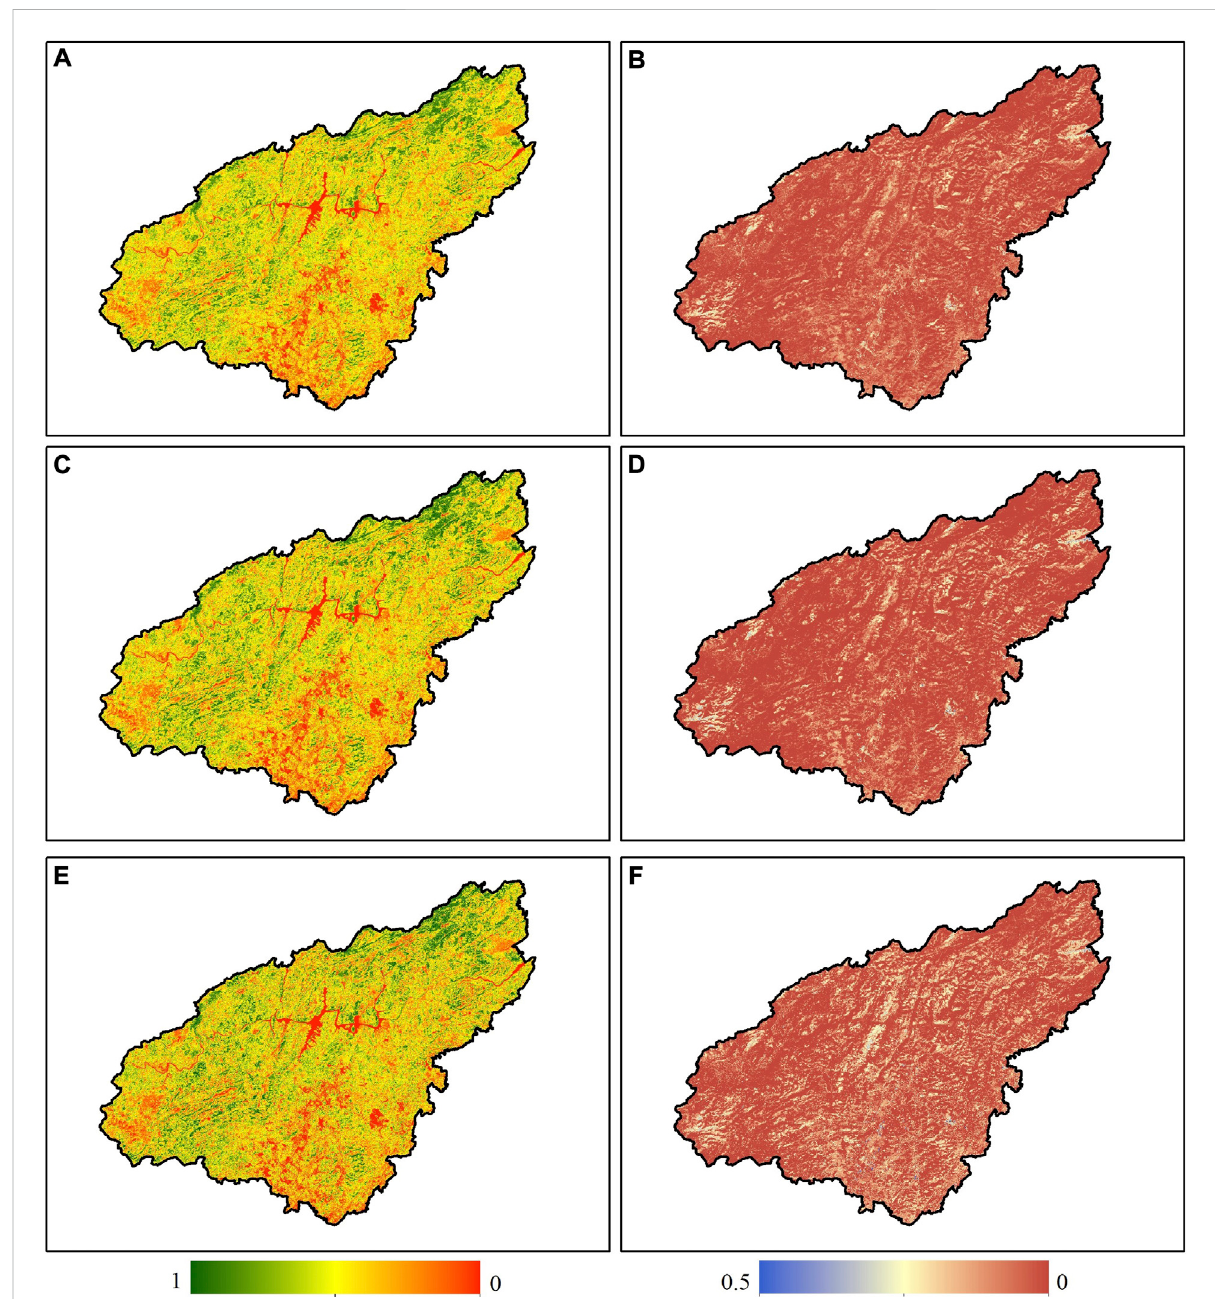
FIGURE 7 f VC and f BR estimation based on Sentinel-2, GF-6, and Landsat 8. (A) f VC of Sentinel-2; (B) f BR of Sentinel-2 and, (C) f VC of GF-6, (D) f BR of Sentinel-2; (E) f VC of Landsat eight and, (F) f BR of Landsat